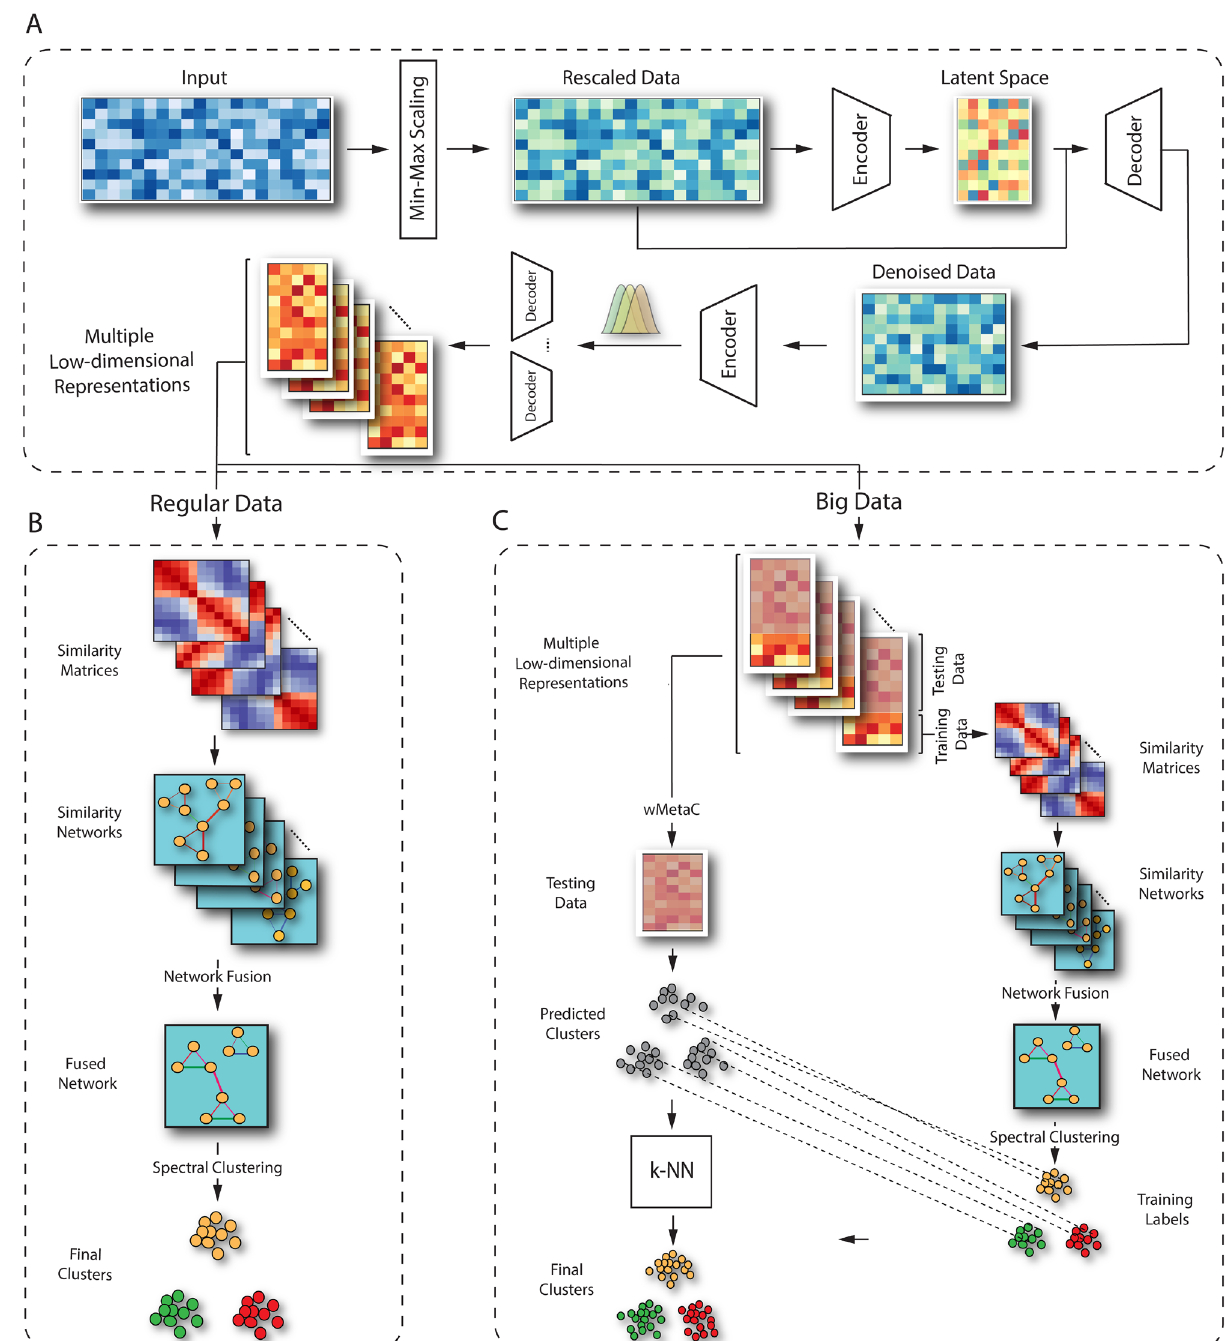
Figure 1. The overall analysis pipeline of scCAN consists of three modules. In the first module ( A ), we perform data normalization, gene filtering, and latent variables generation using two autoencoders. In the second module ( B ), we adopt the network fusion-based clustering method to segregate cell types for small data. The third module ( C ) aims at clustering big data using a combination of the network fusion approach and K nearest neighbors (k-NN)